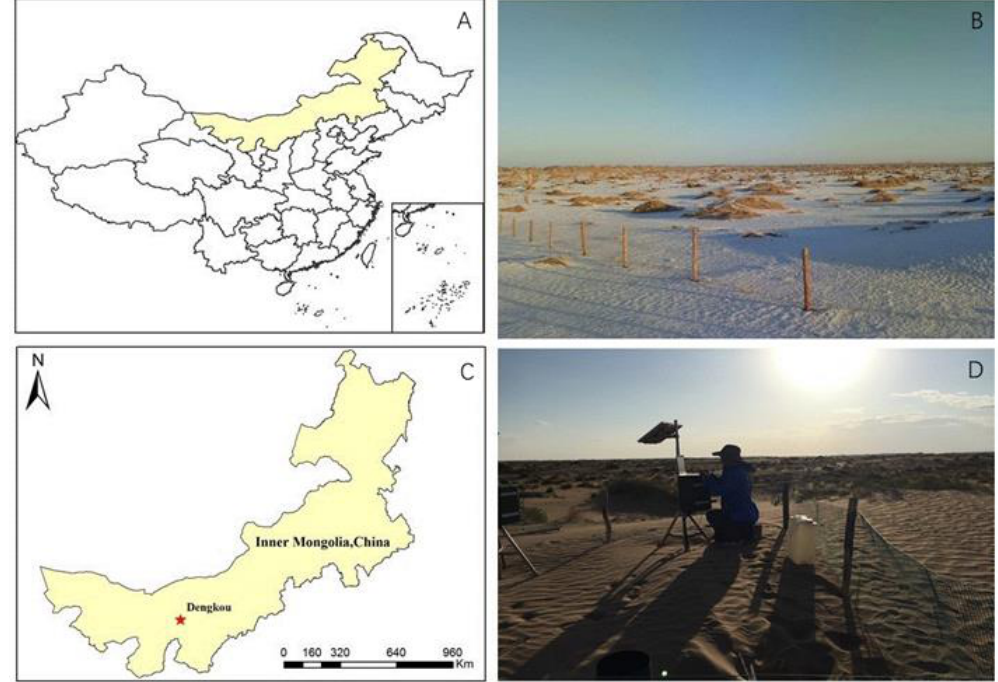
Figure 1. Geographic location of the experimental area. ( A ) refers to the location of the study area in China, ( B ) refers to the area covered by a large amount of snow in winter, ( C ) refers to the location of the study area in the arid and semi-arid area of Inner Mongolia, and ( D ) refers to the landscape of the experimental site.